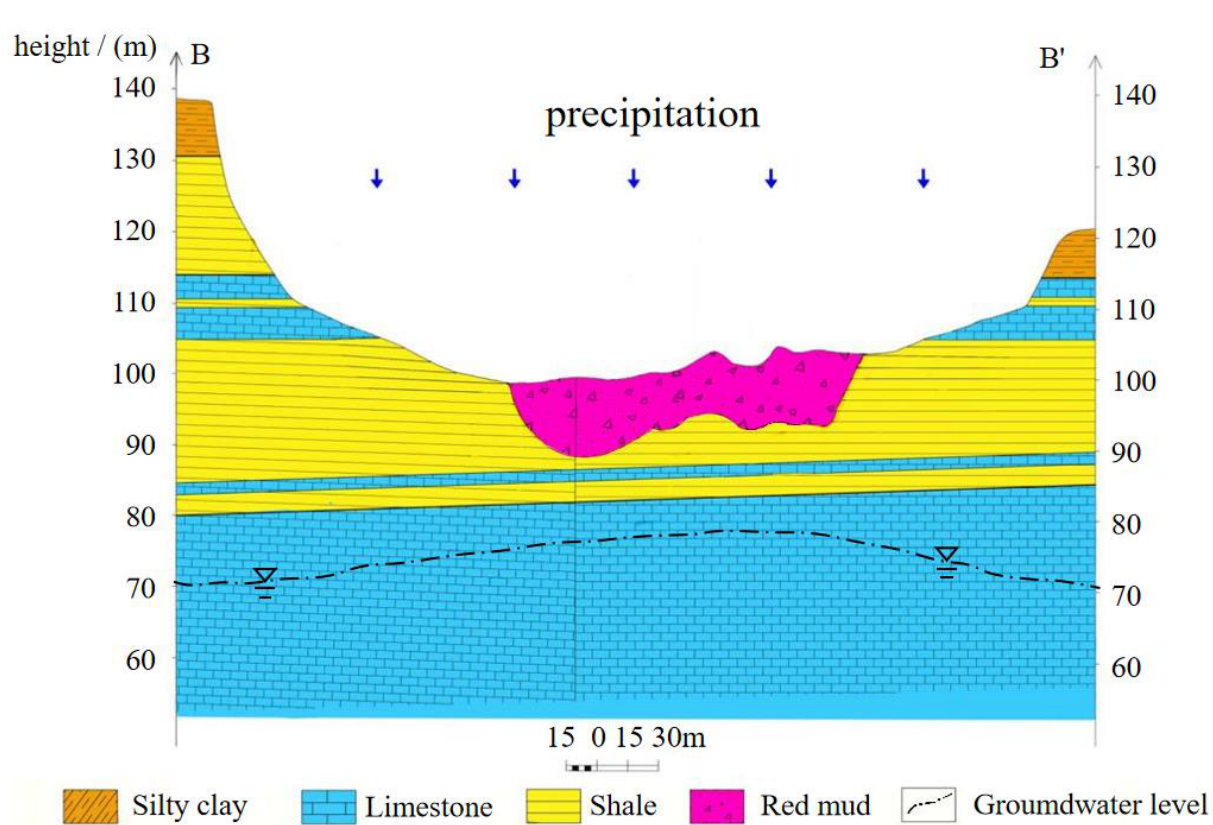
Figure 3. A-A’ Section. Figure 3. A- A’ Section. Figure 3. A- A’ Section.